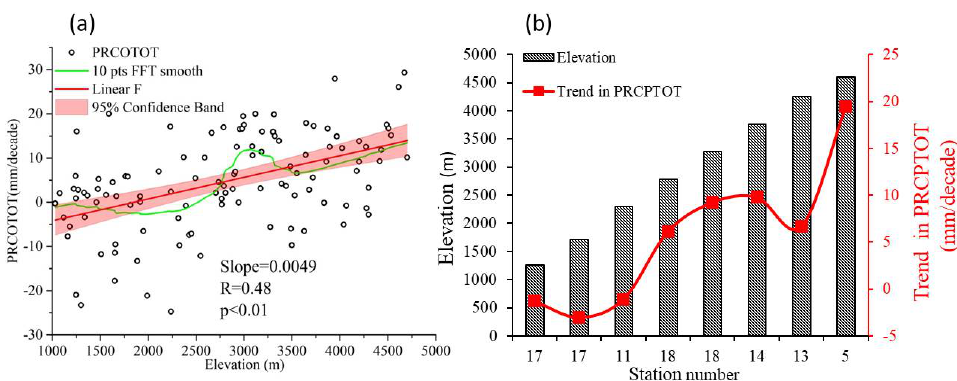
Figure 6. ( a ) Scatter plots of trends (mm/decade) by elevation for PRCPTOT and ( b ) elevation dependence of PRCPTOT trends (mm/decade) in the TP and TPS during 1971–2017. (The numbers in b horizontal axis represent the stations in each 500 m elevation band, and trend magnitude is plotted on the y axis, the trends are the means over individual elevation